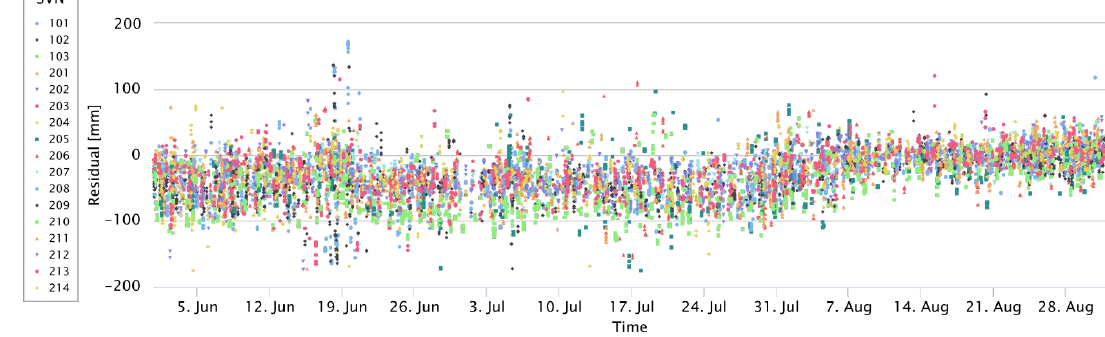
Figure 8. SLR residuals as a function of time for Galileo satellites in period 1 June 2017–31 August 2017.